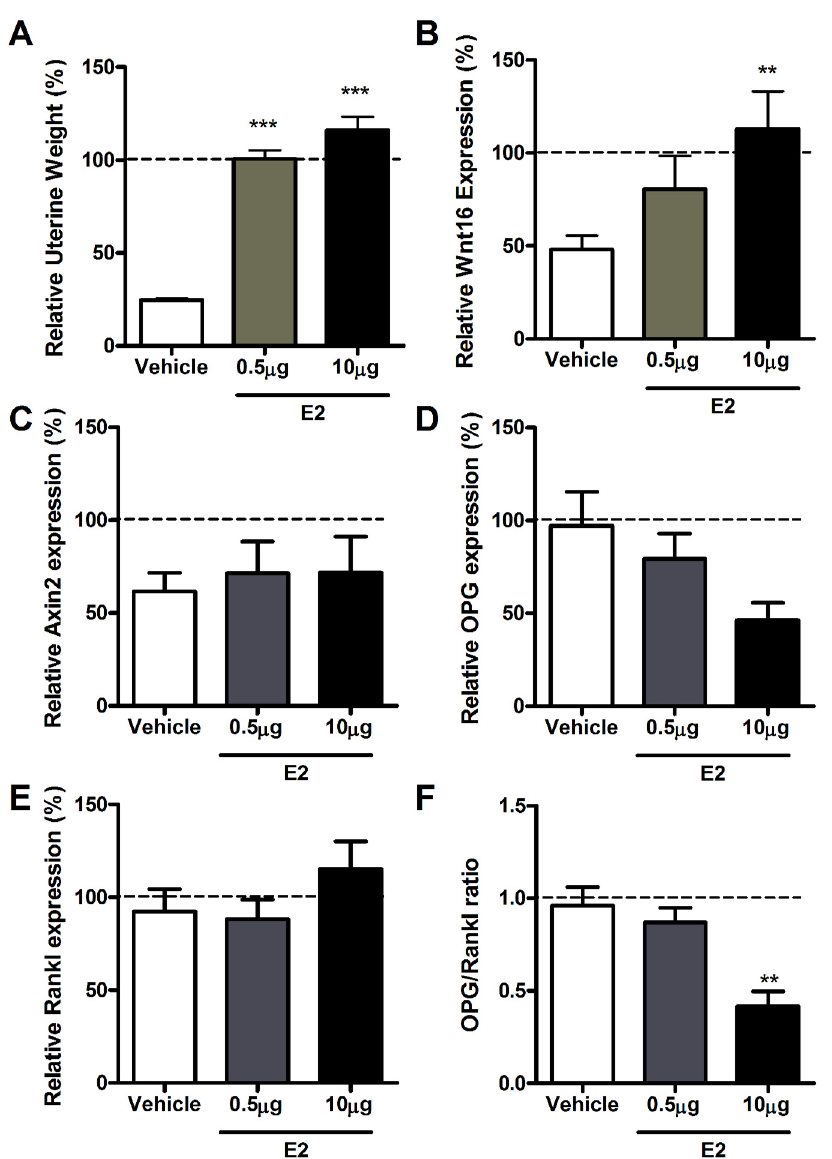
Fig 6. Estrogen treatment enhances Wnt16 expression in cortical bone of young female mice. (A) Both a low (gray bars) and a 20 times higher (black bars) dose of 17 β -estradiol (E2) restored the uterus weight. (B) Wnt16, (C) Axin2, (D) OPG, (E) Rankl and (F) the OPG:Rankl ratio were determined by qRT-PCR in cortical bone from young female mice subjected to sham surgery or ovariectomized and then treated with vehicle, low dose or high dose of E2. Following qRT-PCR analysis, the sham-operated group was normalized to 100%, as indicated by the horizontal dashed line. Bars represent the mean ± SEM. ** = p < 0.01, *** = p < 0.001 vs. vehicle, N =